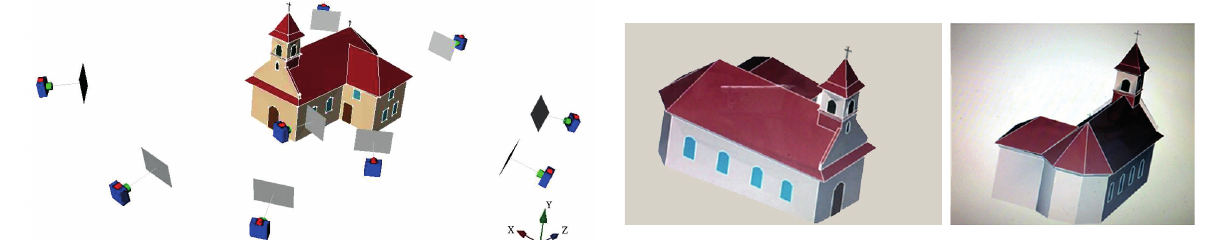
Fig. 7. 3D model with the position of photogrammetric stations (view 2)